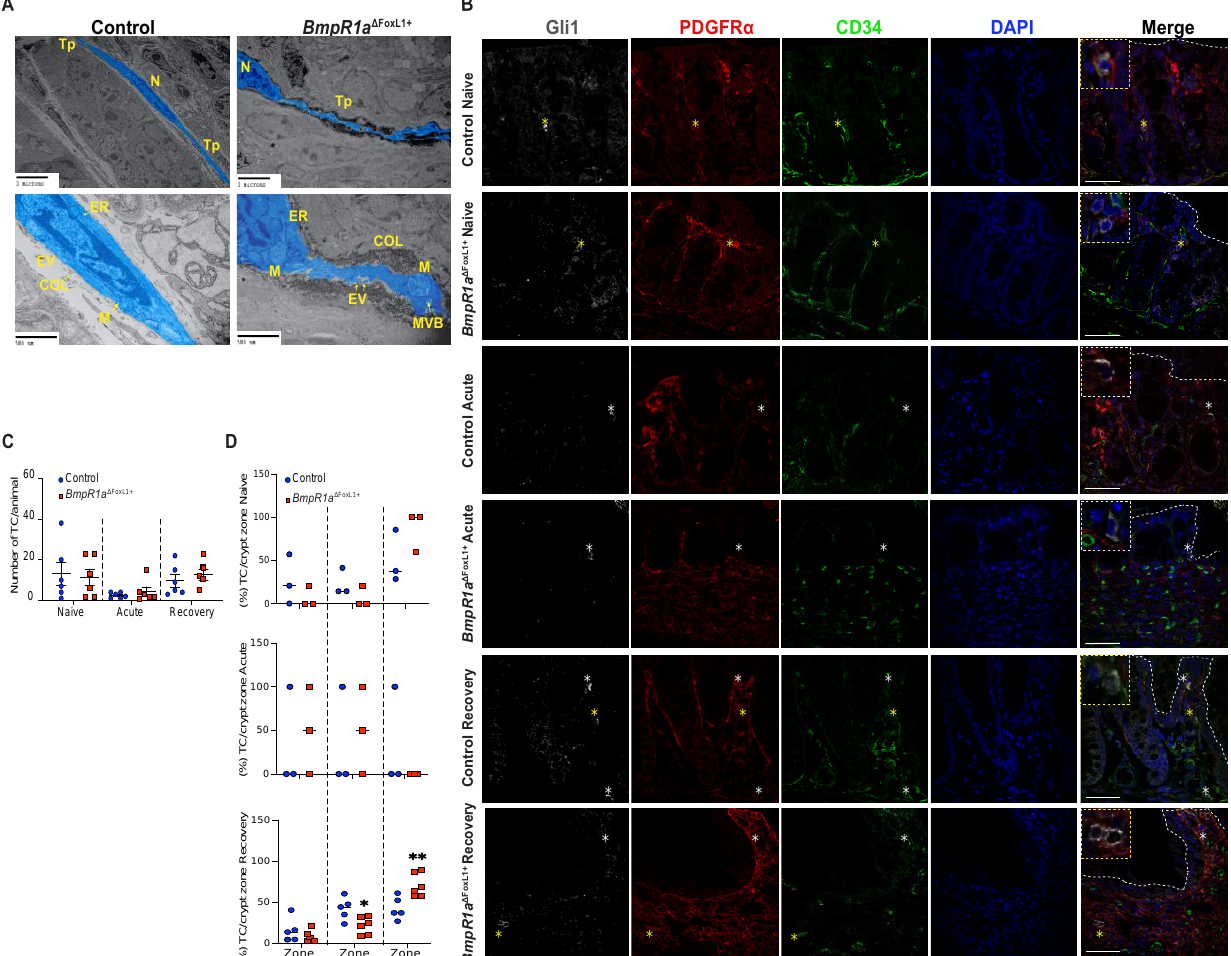
Figure 5. Loss of BMP signalling leads to irregularly shaped telocytes under naive conditions, whereas inflammatory challenge and recovery do not affect its number among groups. ( A ) Ultrastructural analysis of telocytes (blue) present classical features for these cells with small bodies and long telopodes in control and BmpR1a Δ FoxL1+ mice. Presence of irreg- ularly shaped telopodes were observed in BmpR1a Δ FoxL1+ mice. Higher magnification demonstrated increased secretory activities from TC FoxL1+ in BmpR1a Δ FoxL1+ mice as shown by presence of increased collagen fibrils deposition and extracellular vesicles compared with the control. ( B ) Under naive condition, no difference was observed in TC FoxL1+ population numbers (Gli1 + /grey, PDGFRα + /red, CD34 − /green) (yellow asterisks) nor in localisation in regard to the epithelium (white discon- tinuous line) in both groups. Upon acute phase, TC FoxL1+ population was reduced in both control and BmpR1a Δ FoxL1+ mice